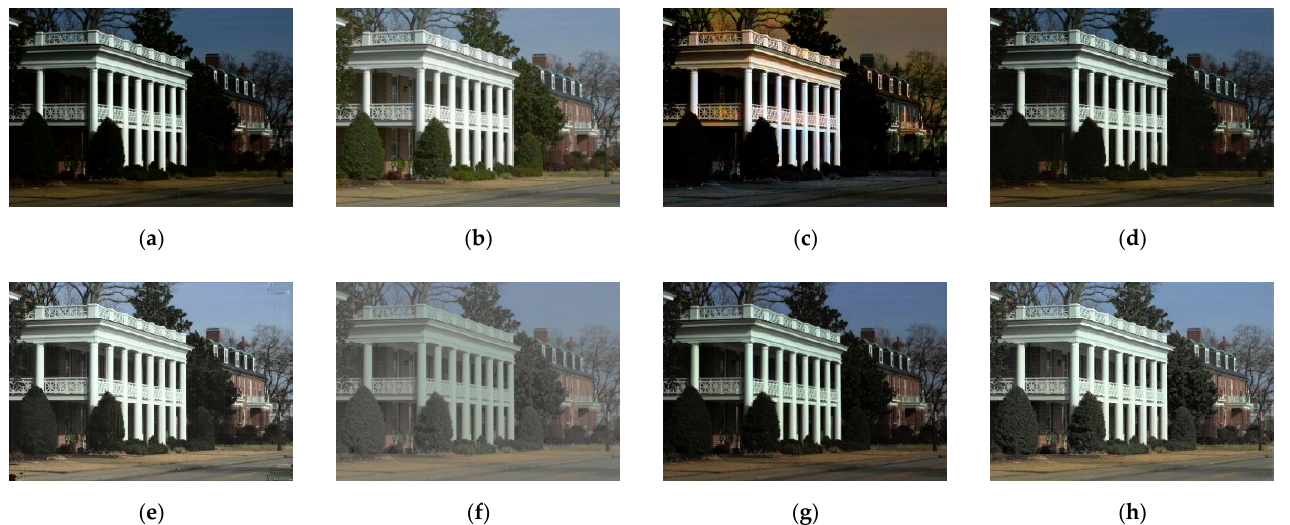
Figure 16. Bright surrounding image #2: ( a ) input, ( b ) target, ( c ) CycleGAN, ( d ) Lum CycleGAN, ( e ) EV GAN, ( f ) HDRCNN, ( g ) ExpandNet, and ( h ) the proposed model. Table 1. Computational time needed for each method.